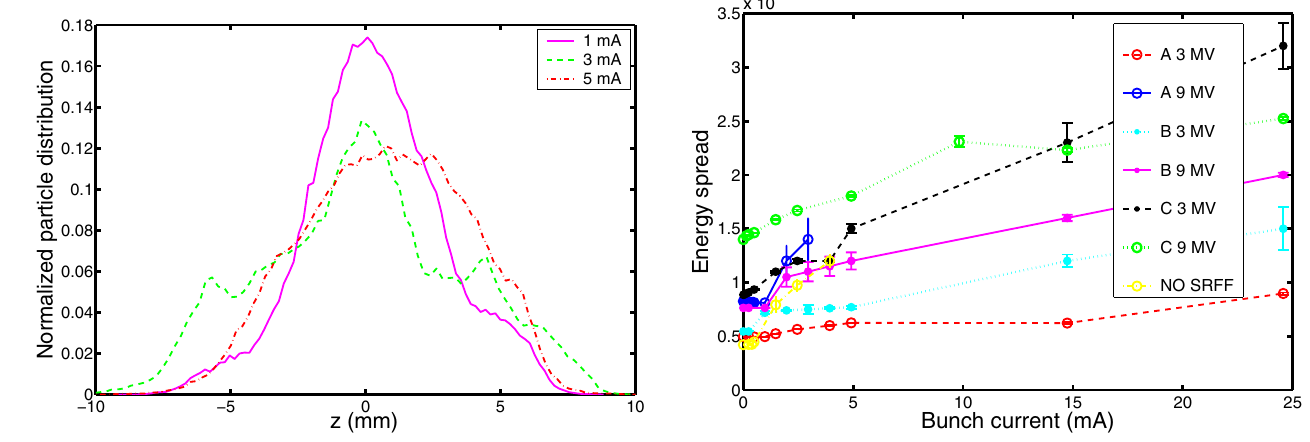
FIG. 11. (Color) Normalized particle distribution for the case B with 3 MV, under the effect of all the wakefields.